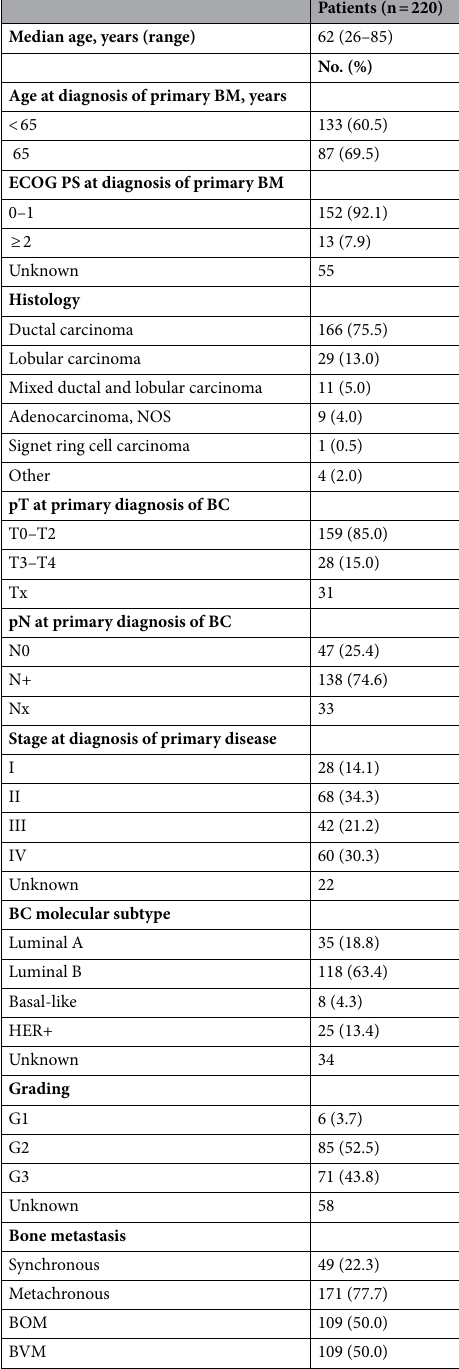
Table 1. Patient characteristics at baseline and at onset of BM. BM bone metastasis, ECOG PS Eastern Cooperative Oncology Group Performance Status, NOS not otherwise specified, BC breast cancer, pT primary tumour, pN pathological lymph node, Nx unknown lymph node stage, G grade, BOM bone-only metastasis, BVM visceral and bone